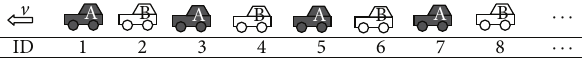
Figure 1: Schematic illustration of platoon “ABAB ...